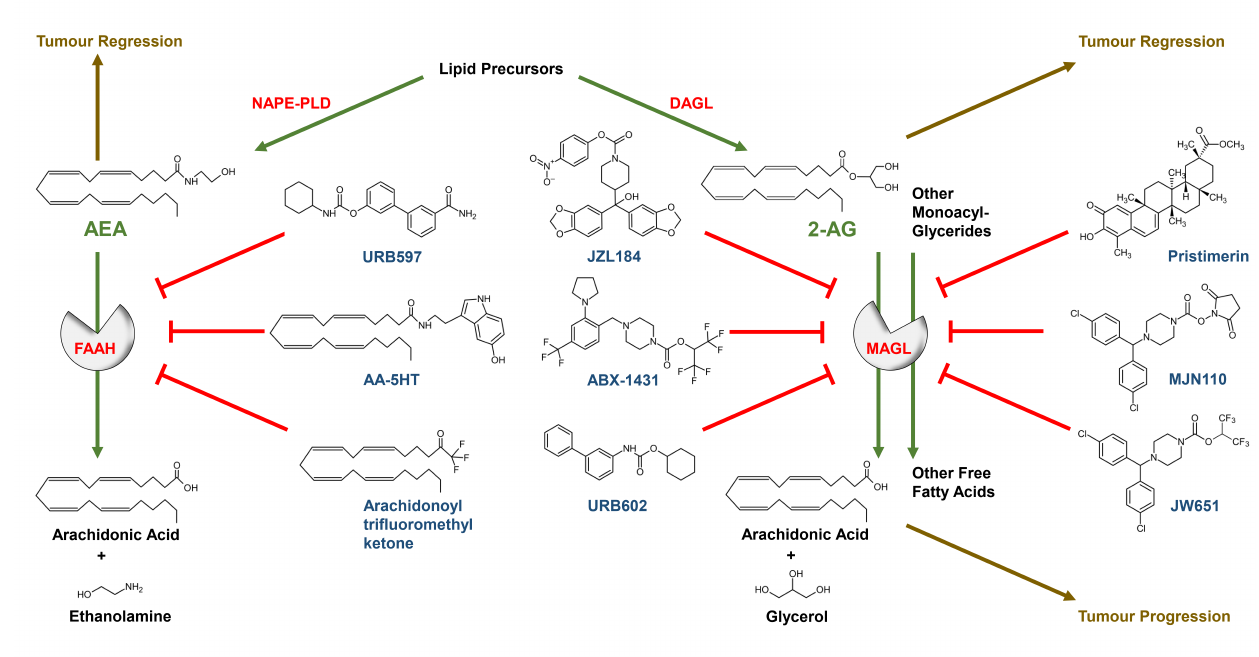
Figure 1. Chemical structures of selected FAAH and MAGL inhibitors, endocannabinoids and their degradation products. Green arrows: enzymatic activity; red blocking arrows: blockade of enzymatic activity; brown arrows/letters: functional influence on tumour development; red letters: enzymes; green letters: FAAH and MAGL substrates; blue letters: inhibitors of enzymes; black letters: starting compound of biosynthesis and metabolic end products of endocannabinoid degradation. For illustration purposes, only the most important enzymes are